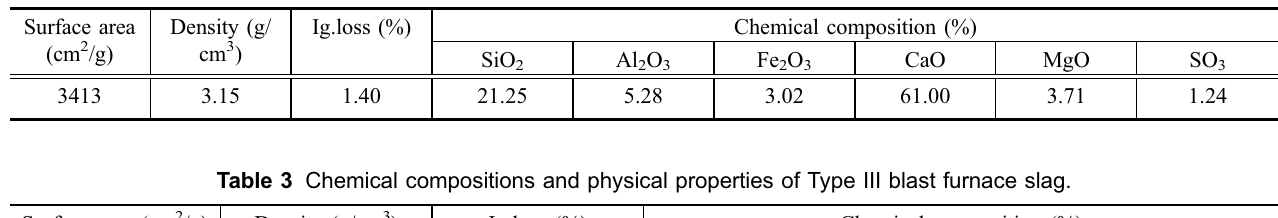
Table 2 Chemical compositions and physical properties of Type I Portland cement.